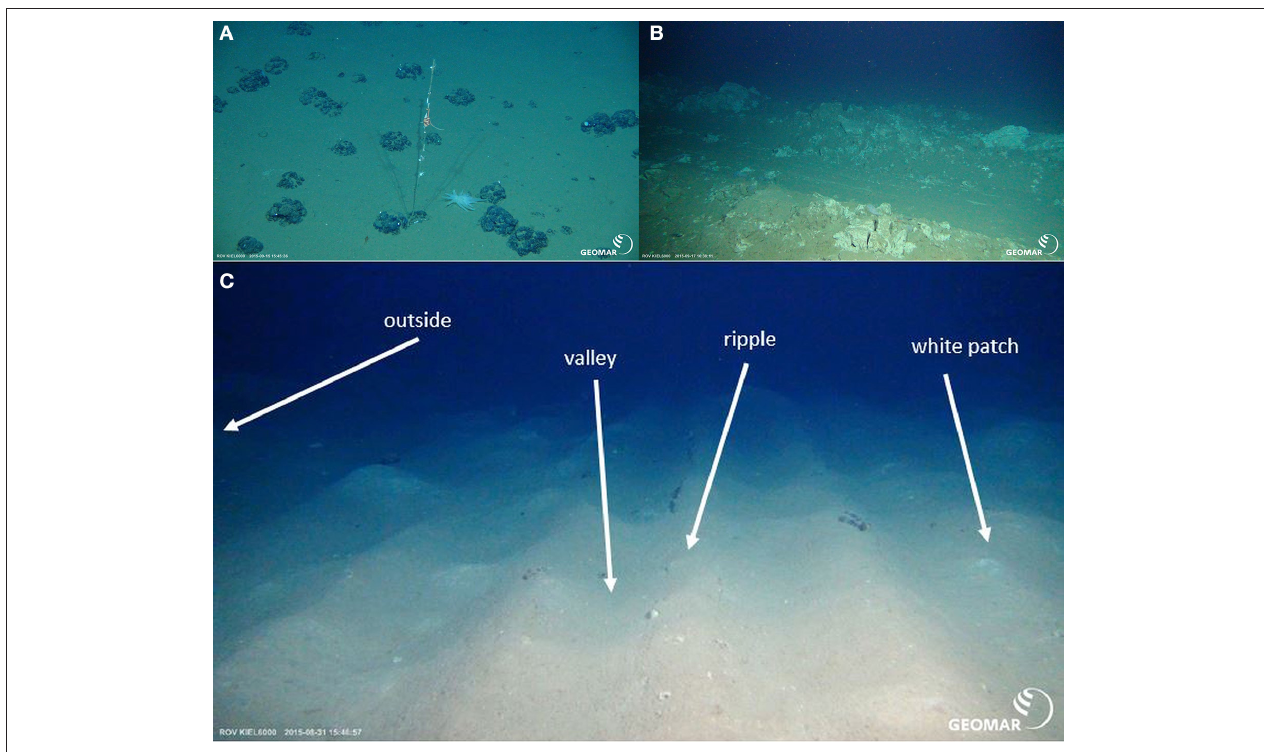
FIGURE 2 | (A) Example of seafloor at a reference site, (B) example of an EBS track, (C) example of a 26-year old plow track, indicating the four microhabitats outside track, track valley, ripple, and white patch. Pictures copyright ROV KIEL 6000 Team, GEOMAR Helmholtz Centre for Ocean Research Kiel, Germany.